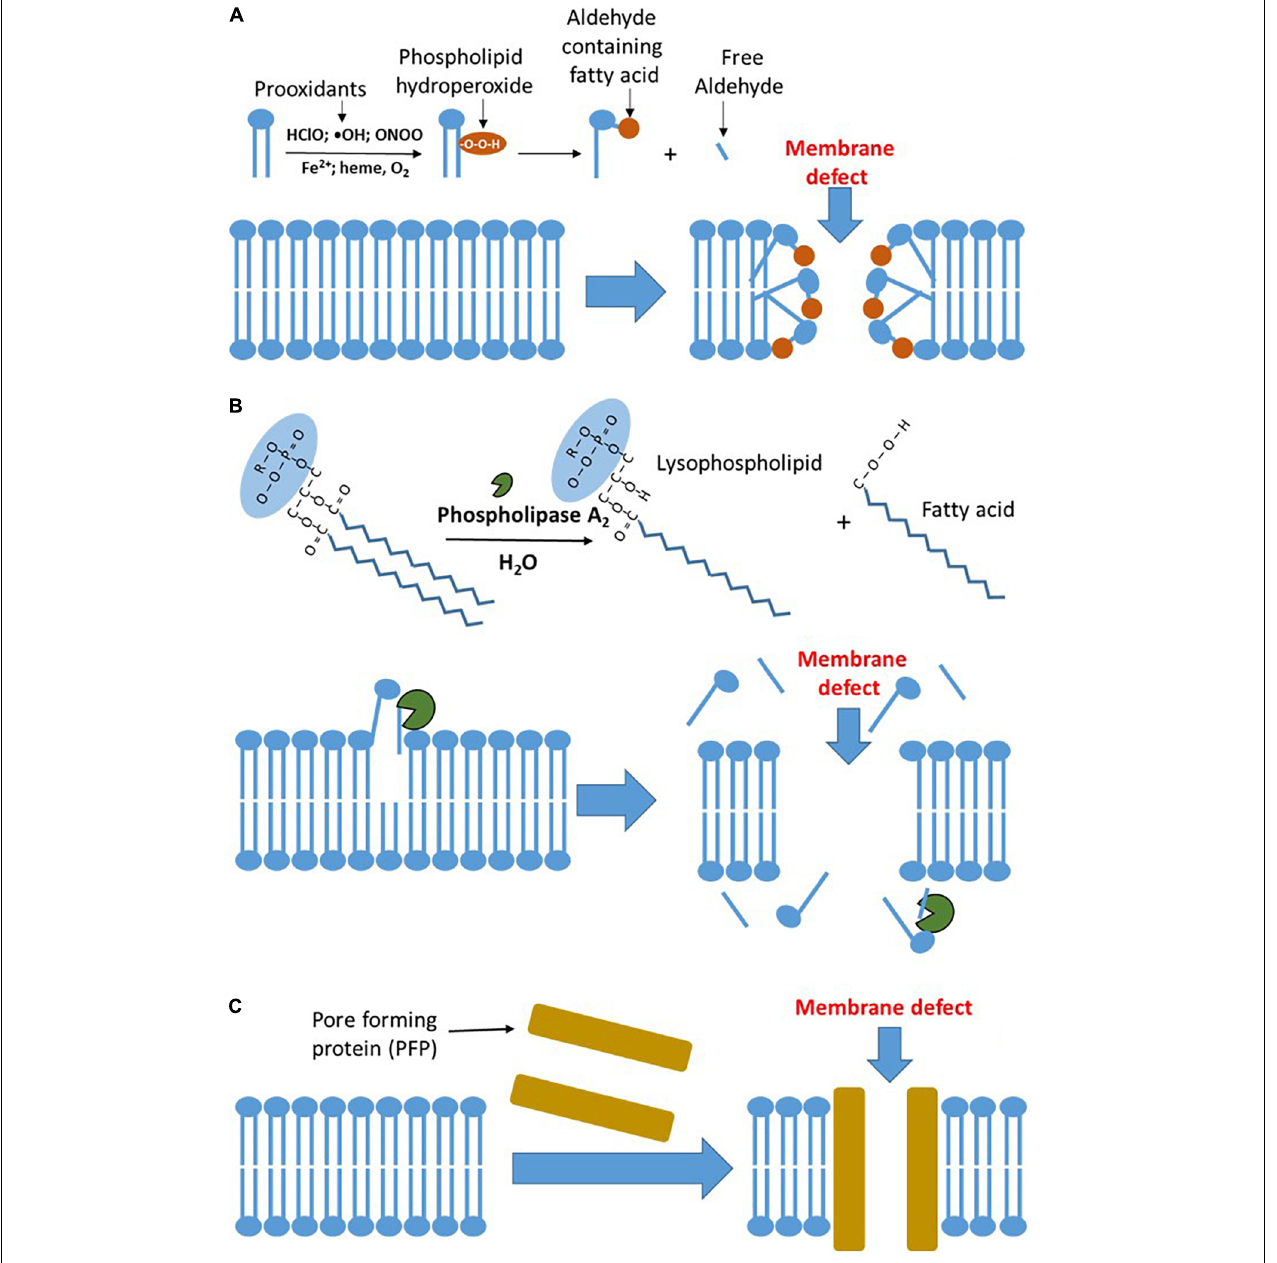
FIGURE 1 | The major mechanisms of plasma membrane damage. (A) Oxidative damage to the plasma membrane. Prooxidants formed by inflammatory sources circulating in the blood induce lipid peroxidation in plasma membranes. The latter results in the formation of polar, hydrophilic species, which form defects in the membrane and increase its permeability. (B) Damage to the plasma membrane mediated by phospholipases. Elevated concentration of phospholipase A 2 (PLA 2 ) in the circulating blood hydrolyzes phospholipids in the plasma membranes. This reaction results in the formation of lysophospholipids and free fatty acids, which are prone to leave the membrane and increase its permeability facilitating lipid peroxidation in plasma membranes. The latter results in the formation of polar, hydrophilic species, which form defects in the membrane and increase its permeability. (C) Pore-forming proteins (PFPs) mediated damage to plasma membrane. Upon binding to lipid membranes, they convert from the soluble form into an oligomeric state, undergo conformational change, and form transmembrane pores, which dramatically increase the membrane permeability. HClO, hypochlorite; ONOO, peroxynitrite; and OH, hydroxyl